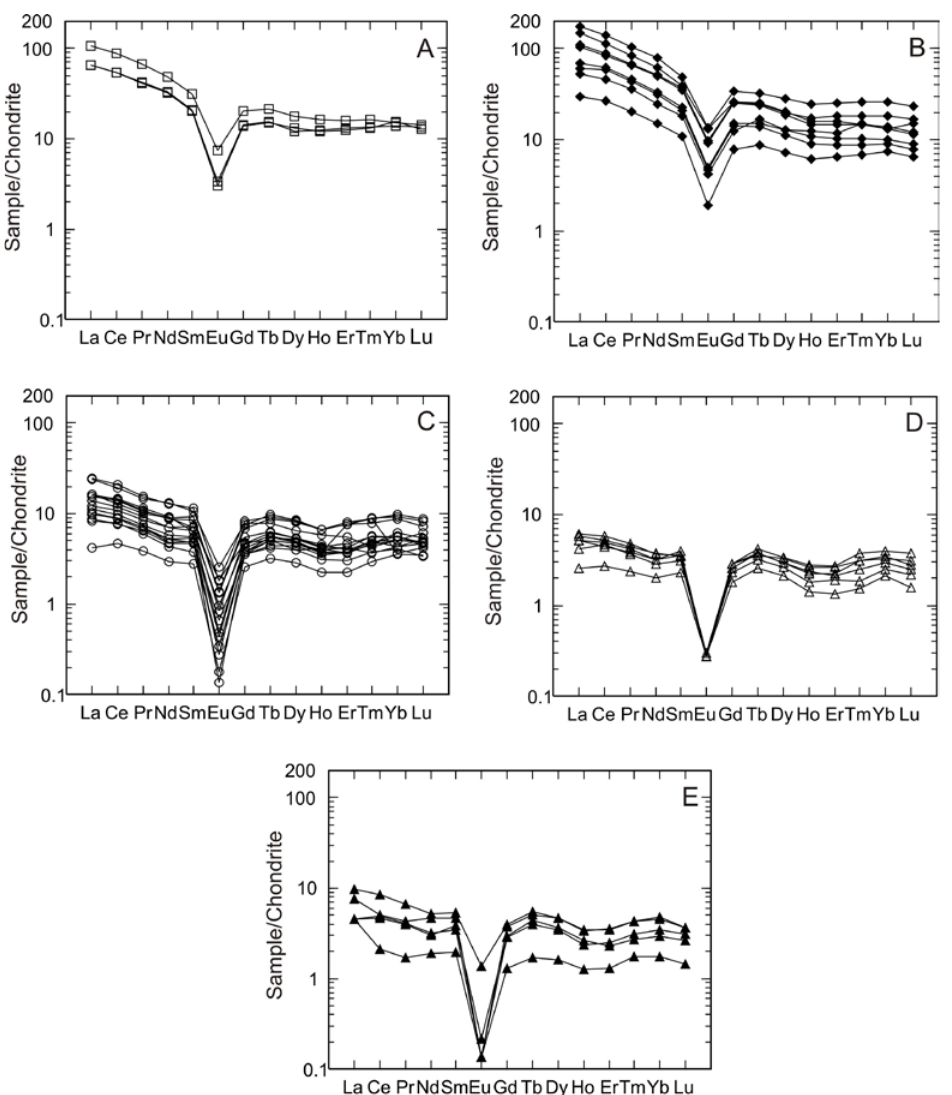
Figure 5. Chondrite-normalized rare earth element (REE) patterns for granitic rocks of the Krudum granite body. ( A ) Chondrite-normalized rare earth element (REE) patterns for medium-F biotite granite, ( B ) Chondrite-normalized rare earth element (REE) patterns for high-F, high-P 2 O 5 two-mica granite, ( C ) Chondrite-normalized rare earth element (REE) patterns for high-F, high-P 2 O 5 Li-mica granite, ( D ) Chondrite-normalized rare earth element (REE) patterns for leucocratic high-F, high-P 2 O 5 Li-mica granite, ( E ) Chondrite normalized rare earth element (REE) patterns for alkali–feldspar syenite. Normalizing values are from [26].